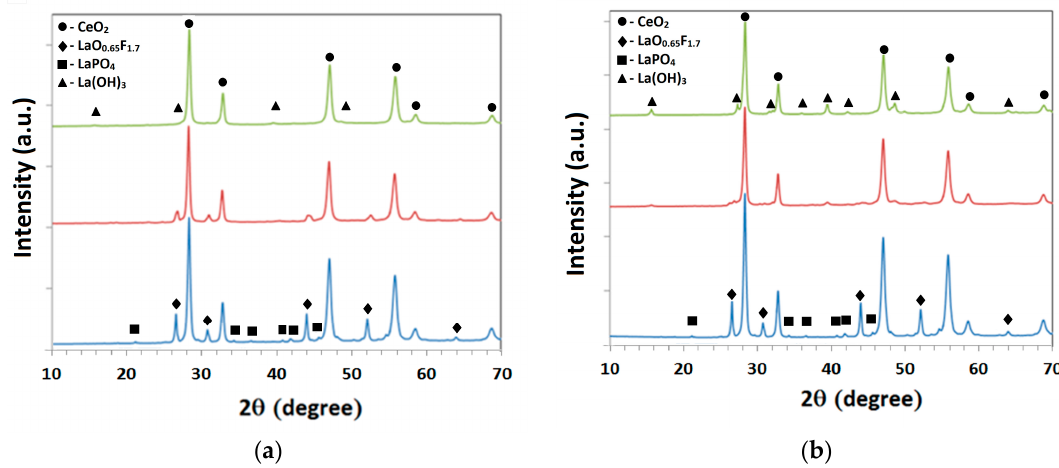
Figure 10. XRD patterns of alkali treated and water leached samples at different alkali to polishing